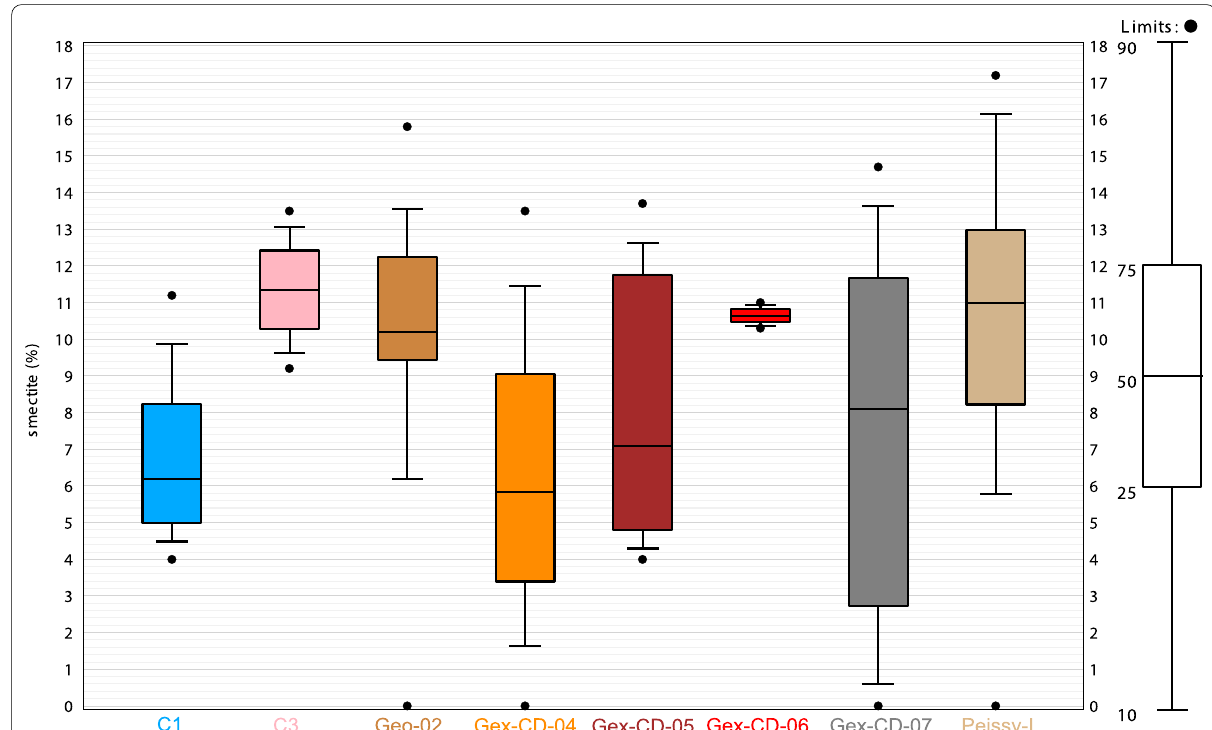
Fig. 16 Overview of swellable clay (smectite) from XRD measurements for 8 wells. The northern wells (Gex-CD-07 and Peissy-I) show a high variability, depicting maximum smectite values of